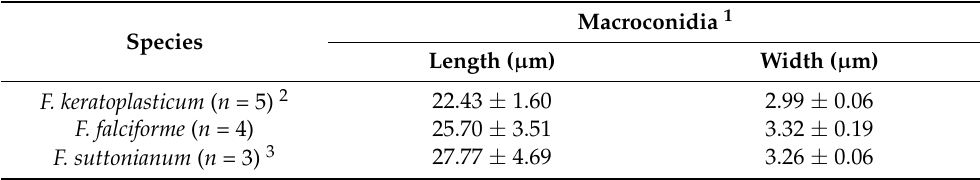
Table 3. Average length and width of Fusarium species macroconidia with 2 or 3 septa. Values are presented as the means ± standard